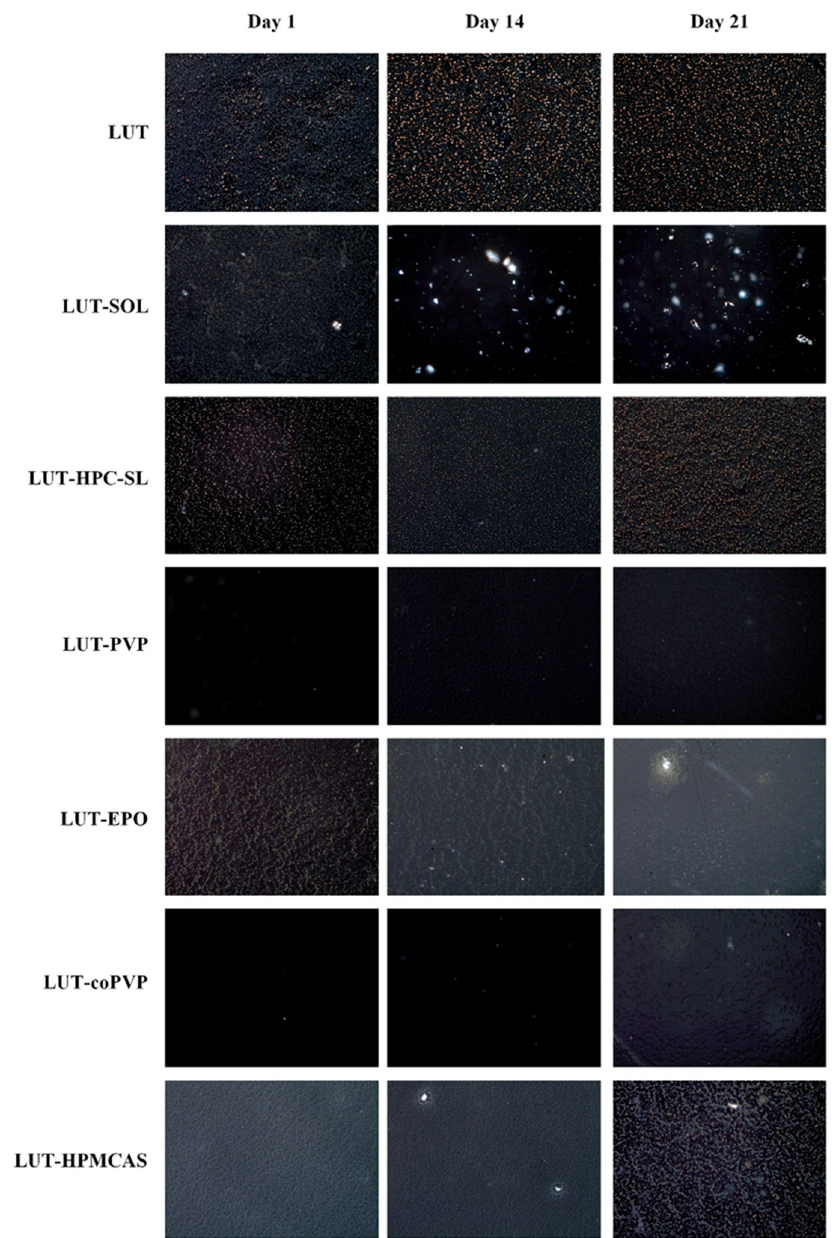
Figure 2. PLM photographs of neat LUT and LUT-matrix/carriers’ binary thin films after 1, 14, and 21 days of storage.